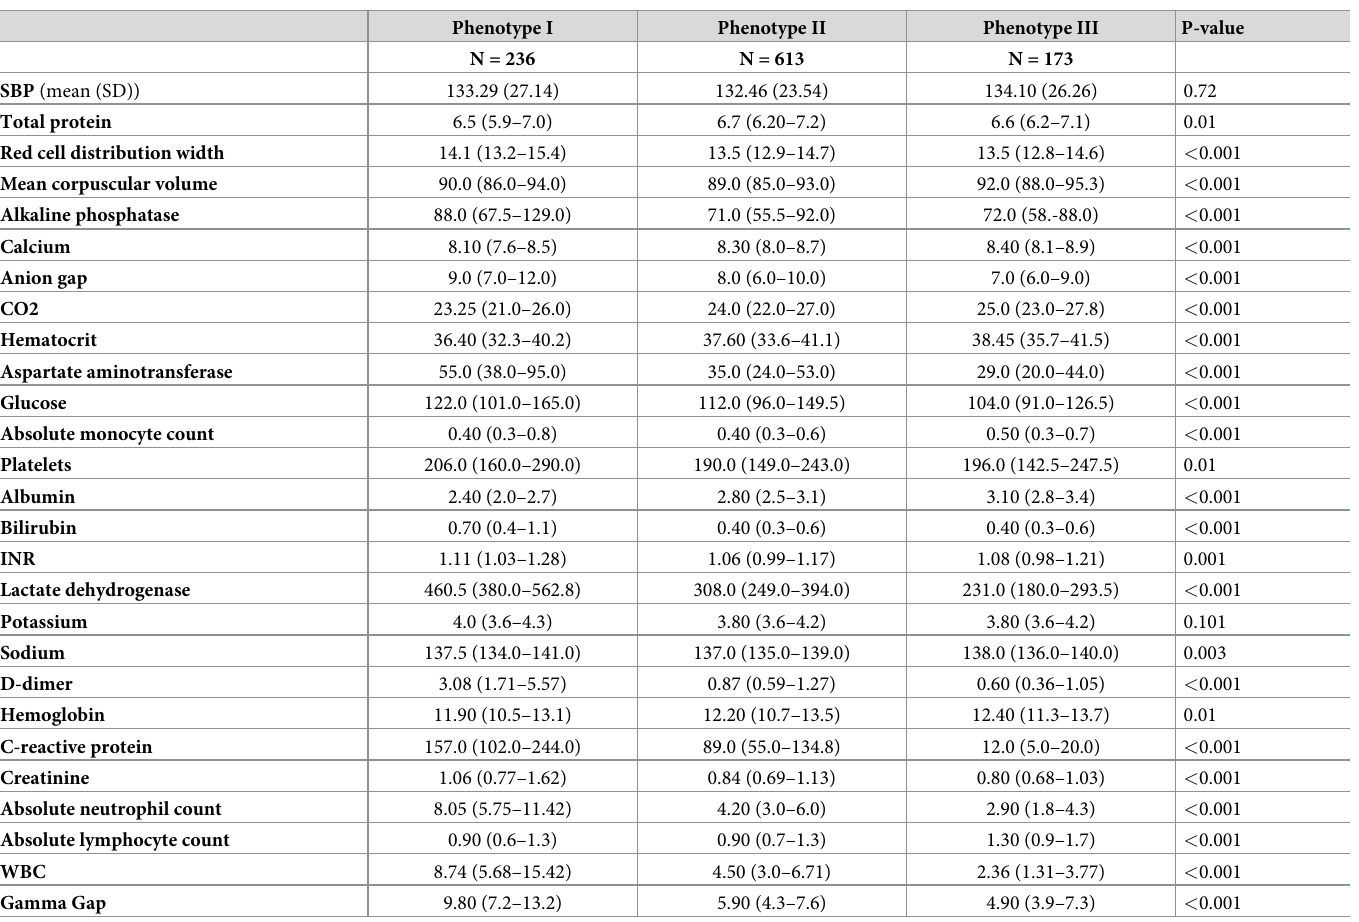
Table 1 presents summary statistics of patient demographics, comorbidities, in-hospital complications, clinical outcomes, and admission vitals and labs for each clinical phenotype (I, II, III). Admissions vitals and labs were used to create the phenotypes. Categorical variables are presented as count (%). Continuous variables are presented as median (interquartile range) unless otherwise